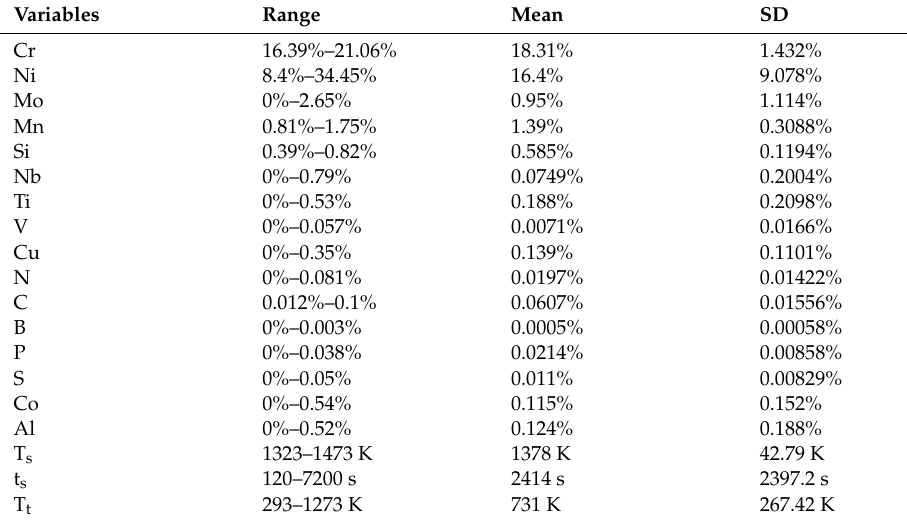
Table A1. The 415 samples with water quenching after solution treatment (label: 1).